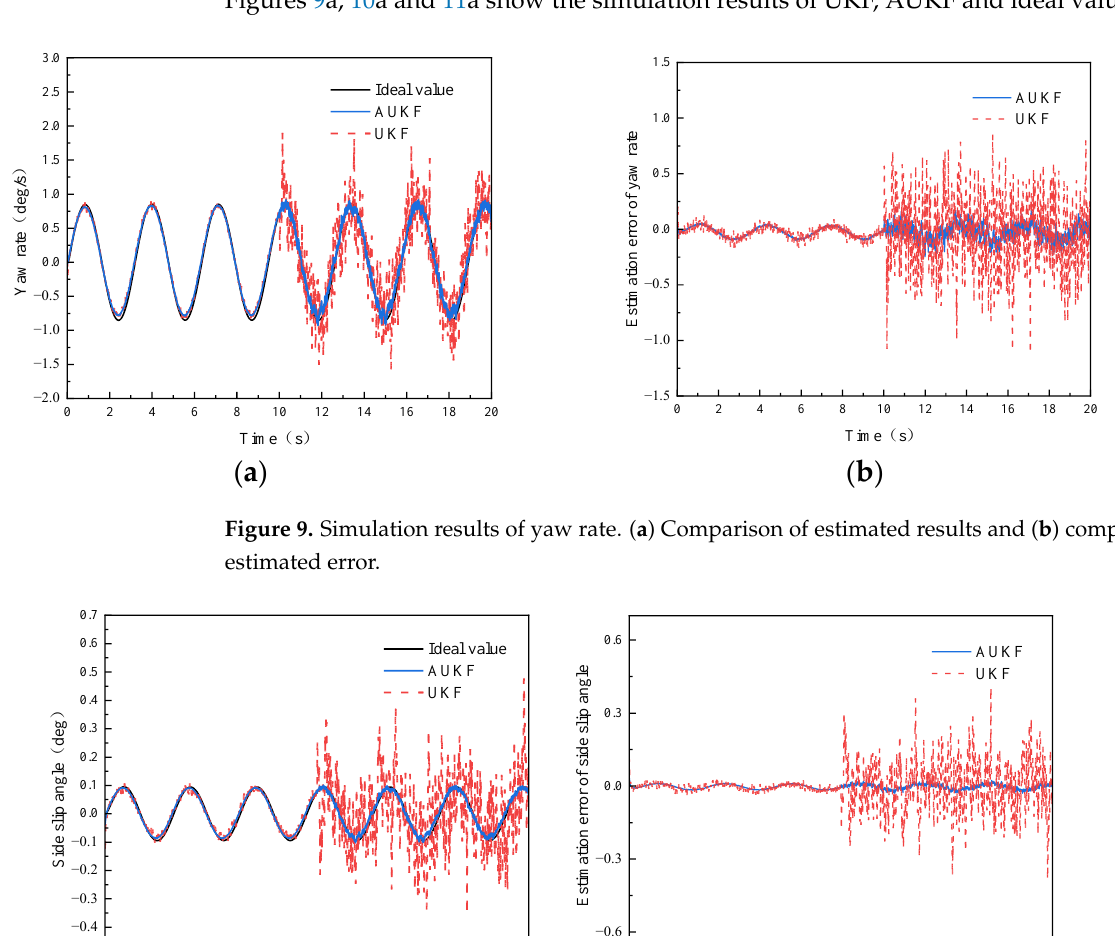
( b ) Figure 11. Simulation results of longitudinal velocity. ( a ) Comparison of estimated results and ( b ) comparison of estimated error. In Figure 9a, we can see that the standard UKF estimates a divergence at the inflection point of the curve during 0–10 s, while the AUKF can track the ideal value effectively. At the same time, due to the change in process noise after 10 s, the divergence phenomenon of the UKF is more obvious in the estimation, and this fluctuation is larger than that seen during the first 10 s, which shows that the UKF algorithm cannot accurately estimate the corresponding state parameters when there are different degrees of noise disturbance. However, the estimation results of the AUKF algorithm are largely consistent with the ideal values in the whole working condition, and the effect of the AUKF algorithm is ideal. The maximum instantaneous error of the yaw rate is 0.247 deg/s. In Figure 10a, we can see that the standard UKF estimates a divergence at the inflec- tion point of the curve during 0–10 s, while the AUKF can track the ideal value effectively. At the same time, due to the change in process noise after 10 s, the divergence phenome- non of UKF is more obvious in the estimation, and this fluctuation is larger than that seen in the first 10 s, which shows that the UKF algorithm cannot accurately estimate the cor- responding state parameters when there are different degrees of noise disturbance. How- ever, the estimation results of the AUKF algorithm are largely consistent with the ideal values in the whole working condition, and the effect of the AUKF algorithm is ideal. The maximum instantaneous error of the side slip angle is 0.038 deg.